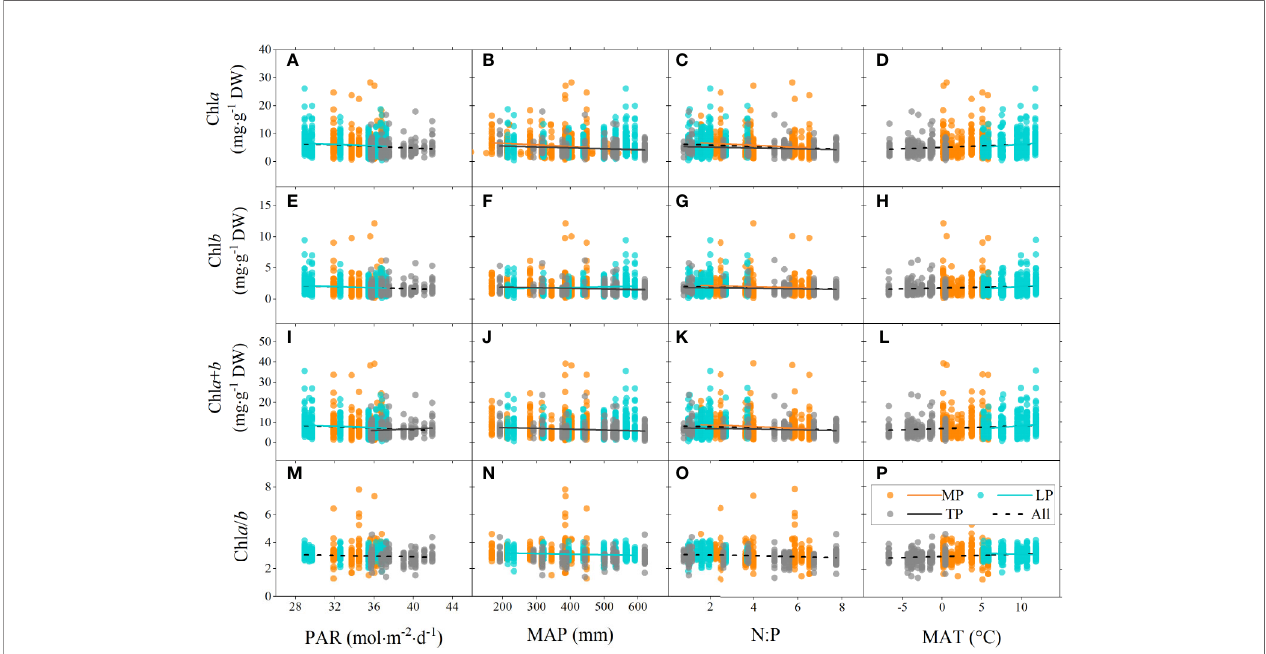
FIGURE 4 | Linear regressions of chlorophyll concentrations (chl a , chl b , and chl a + b ) and ratio (chl a / b ) to major environmental factors grouped by regions. (A – D) , (E – H) , (I – L) , and (M – P) denote regressions of chla, chlb, chla+b, and chla/b to four environmental factors, respectively. MP, Mongolia Plateau; LP, Loess Plateau; TP, Tibet Plateau; PAR, photosynthetic active radiation; MAP, mean annual precipitation; N:P, the ratio of soil nitrogen to soil phosphorus; MAT, mean annual temperature. Lines denote signi fi cant linear fi tted relationships ( p < 0.05).